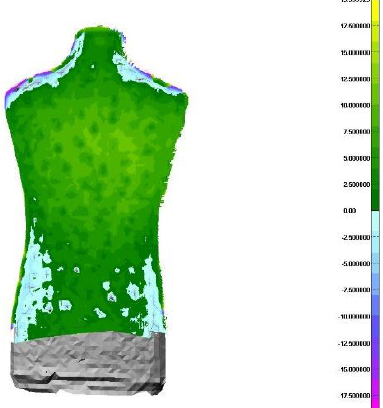
Figure 13 Deviation map between NextEngine 3D model and our proposed system model, scale in